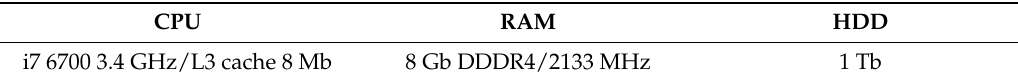
Table 6. Hardware